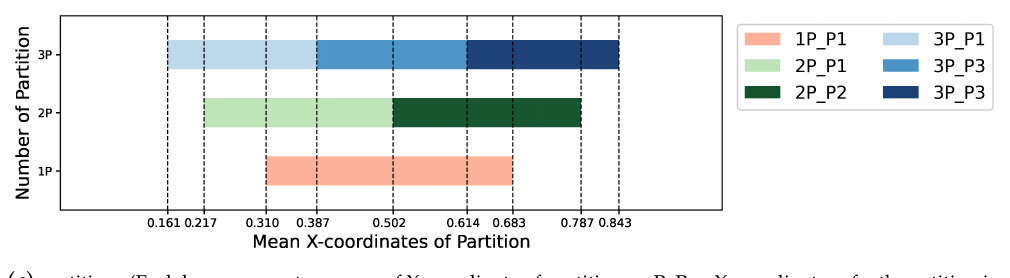
Figure 4. Distribution of randomly generated attributes. All these distributions show the large coverage of lines covered by the algorithm. ( a ) Minimum (blue dots and maximum (red dots) points. Lines are drawn to pass the minimum and the maximum. ( b ) The initially selected two points of a line. They were all randomly selected and the leftmost point is the starting point and the rightmost point is the ending point. ( c ) The distribution of X-coordinates of the boundaries. In each box, the X-coordinates are randomly